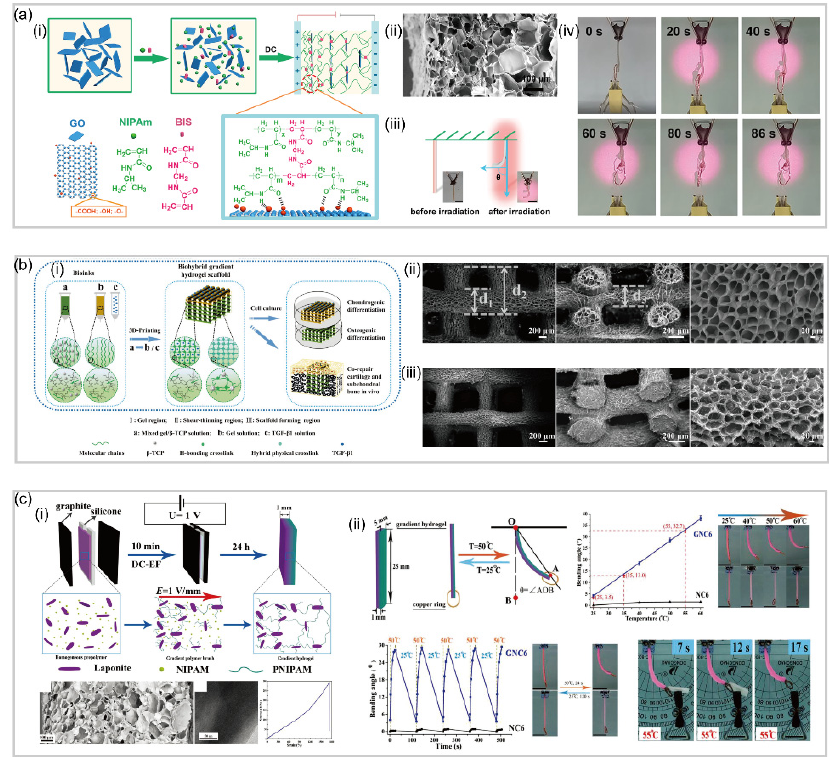
Figure 5. Gradient-based hydrogel soft robotics. ( a ) Photo/thermal-responsive PNIPAm/GO gradient hydrogel actuator (reproduced with permission from Reference [67]). ( b ) Thermal-assisted extrusion 3D printing of the biohybrid gradient scaffolds for repair of osteochondral defect and SEM images of the printed porous hydrogel scaffolds (reproduced with permission from Reference [68]). ( c ) Thermal-responsive pNIPAm/Laponite hydrogel actuator (reproduced with permission from Reference [71]).